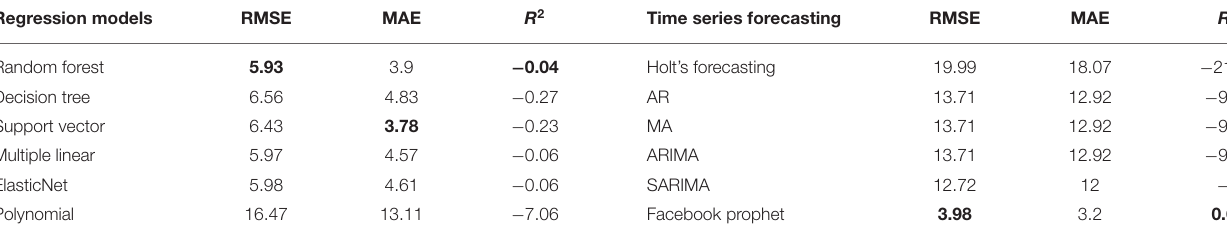
TABLE 10 | Performance metrics comparison table for